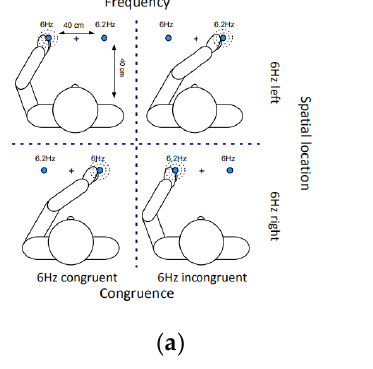
Figure 9. Experimental design and results. ( a ) Subjects’ left finger (or right finger) was continuously vibrated at a constant frequency while subjects looked at the continuously flashing light source. The frequencies of tactile and visual stimuli were designed to intersect at 6 Hz and 6.2 Hz. ( b ) Spectra in the frequency domain. The values 12 Hz and 12.4 Hz are second-order harmonics of 6 Hz and 6.2 Hz respectively. Additionally, 12.2 Hz is the second-order intermodulation component (IM).